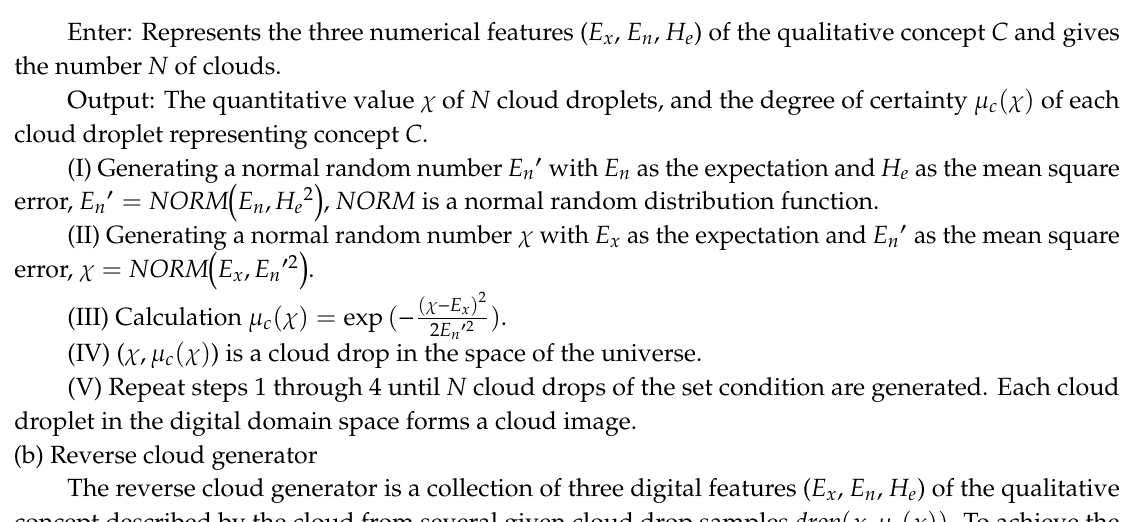
Figure 4. Forward Cloud Generator.